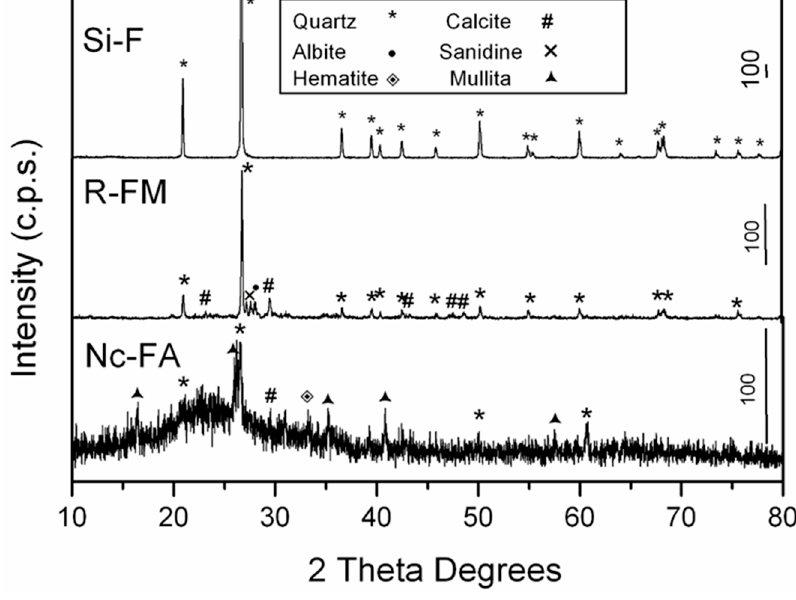
Figure 4. PXRD patterns of Si-F, Nc-FA and R-MF.